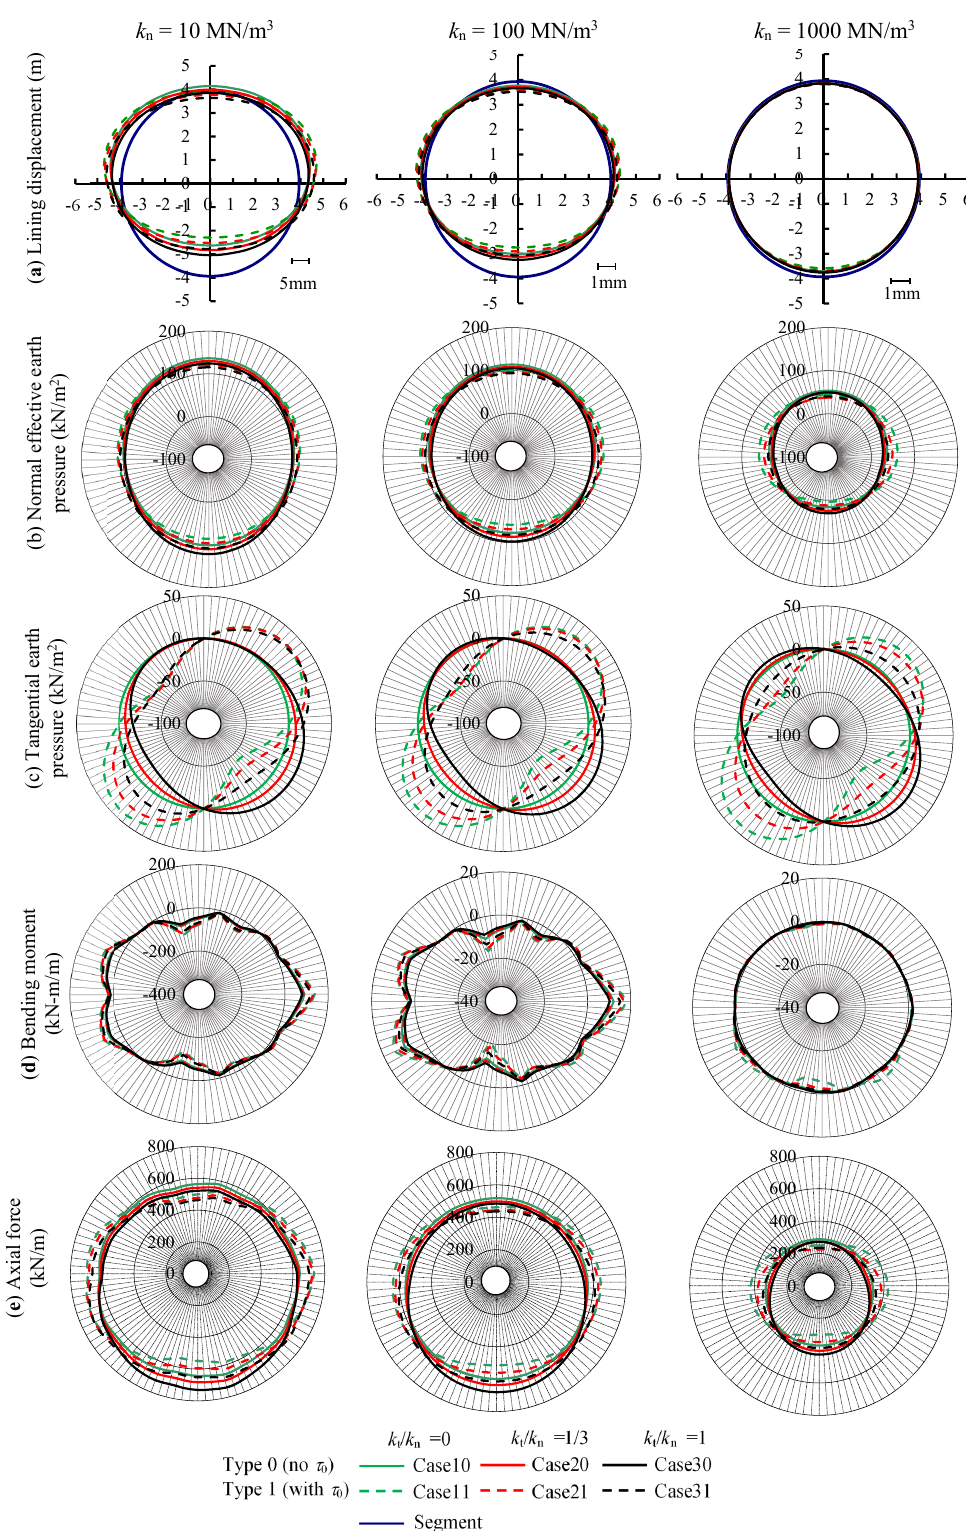
Figure 8. Lining displacement and ground reactions (shallow tunnel).